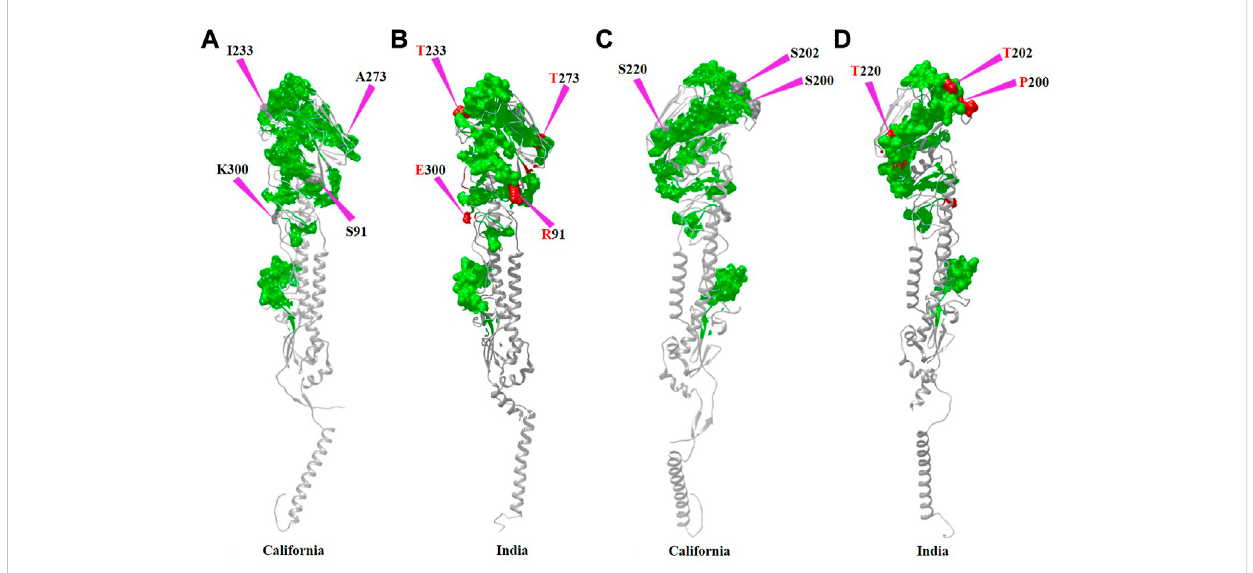
FIGURE 2 Receptor-binding sitesofHA Cal (green surface) aredepicted in (A,C) ,whereas thoseofHA Ind-2018 areshown in (B,D) .Additionalmutations observed inHA Ind areshownintheredsurfaceandalsoindicatedbypurplearrows.Todepictthemutationalsitesclearly,bothfront (A,B) andback (C,D) viewsofHA proteins are